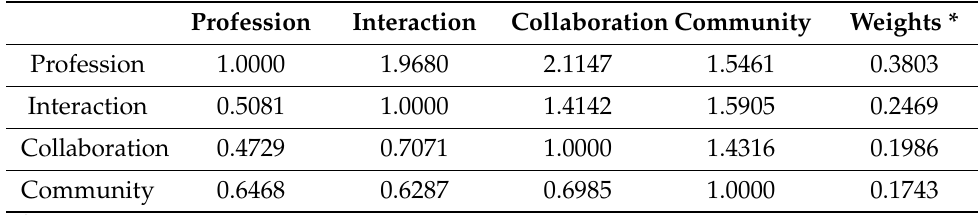
Table 3. The pairwise comparison matrix and weights of the dimensions.